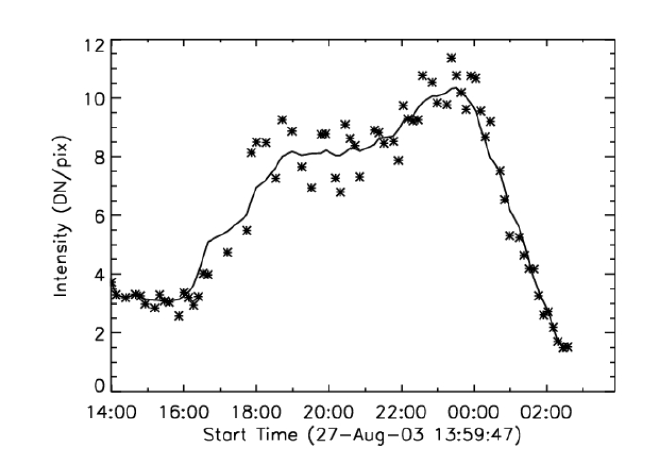
Figure 9: X-ray light curve observed with the SXI telescope on board GOES. The loop lifetime is much longer than the characteristic cooling times. Courtesy of J. A. Klimchuk and M. C. L´opez